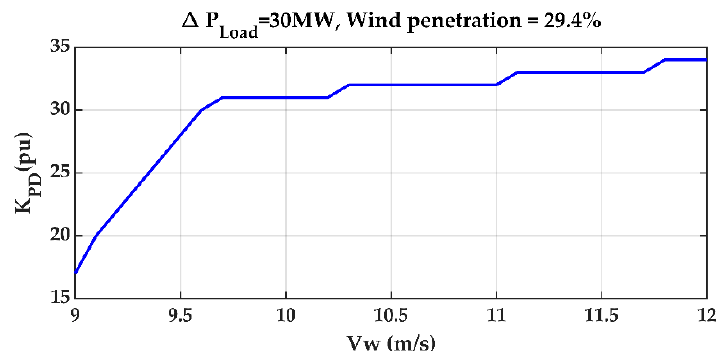
Figure 6. Optimal gain K PD as a function of the wind speed V W ( ∆ P Load = 30 MW and wind penetration = 29.4%).